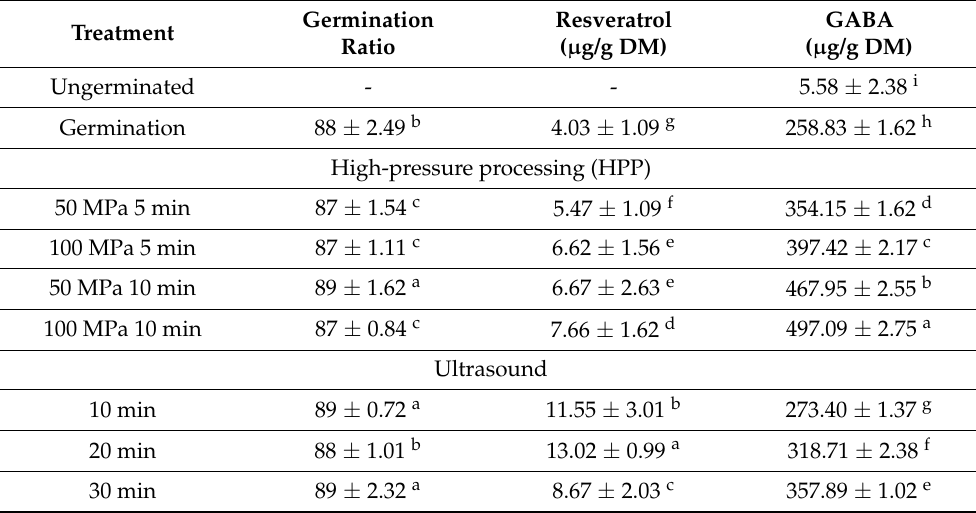
Table 4. Effects of high-pressure processing (HPP) and ultrasonic treatment on the germination ratio, resveratrol, and GABA content of germinated